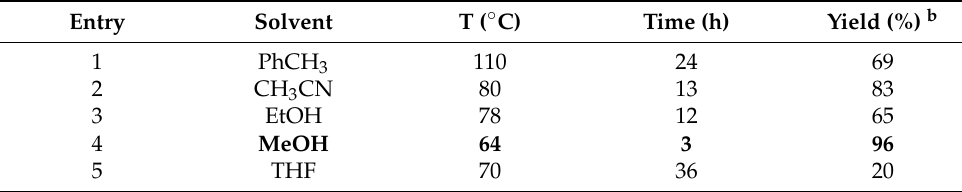
Table 1. Optimization of the reaction parameters for the synthesis of 5d a.